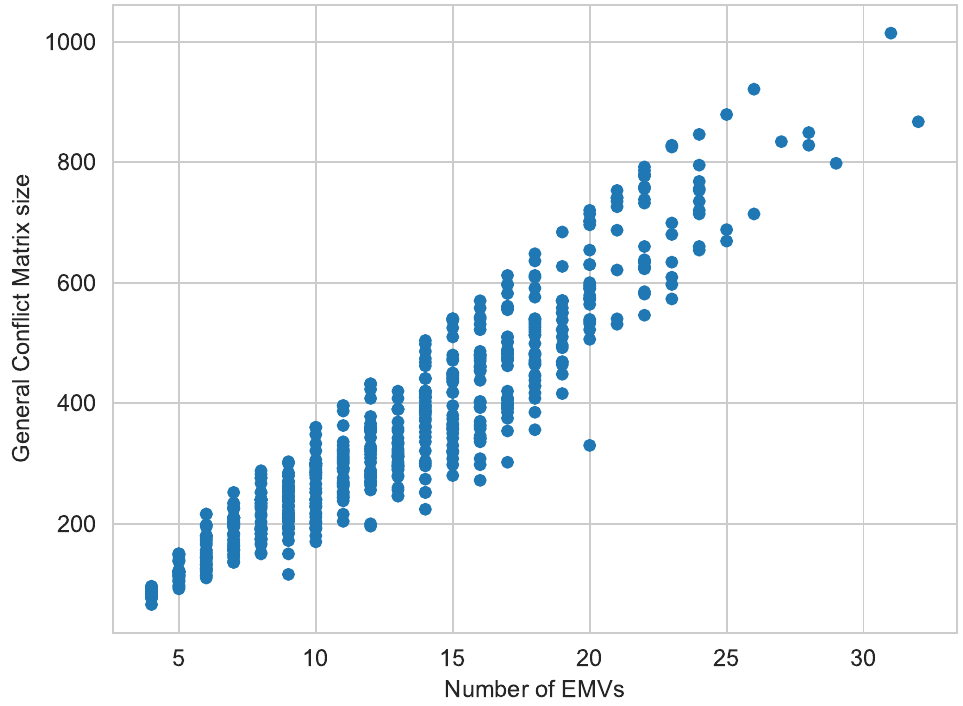
Figure 11. The size of the GCM size with respect to the number of EMVs in a problem instance. The values were obtained directly from the D-wave’s leap platform. The precise meaning of those metrics may be found in [28], where many helpful tutorials and guides are